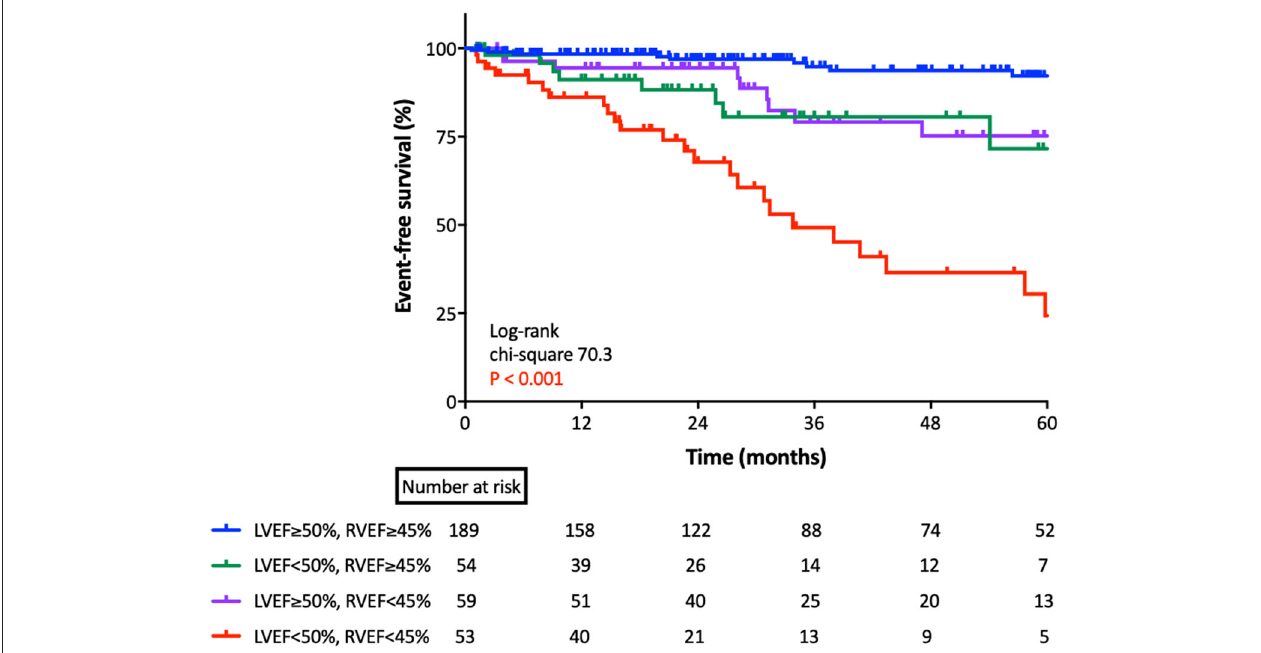
FIGURE 4 | Kaplan-Meier survival analysis for cardiac events based upon RVEF and LVEF. Kaplan-Meier analysis for cardiac events, according to group, as classified by lower limits of normal LVEF and RVEF. LVEF, left ventricular ejection fraction; RVEF, right ventricular ejection fraction.